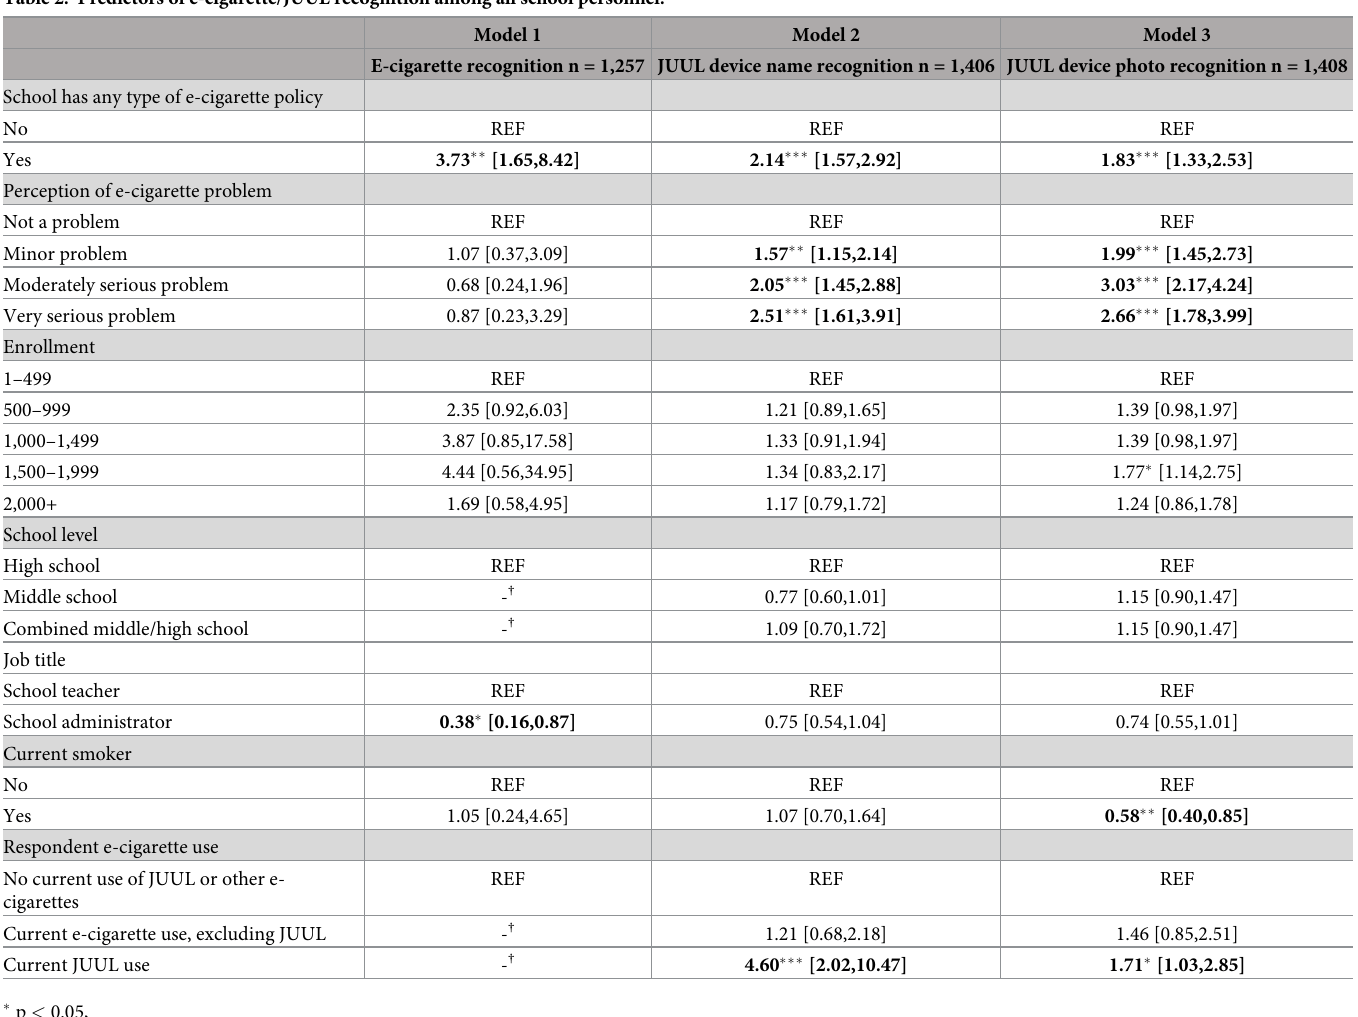
Table 2. Predictors of e-cigarette/JUUL recognition among all school